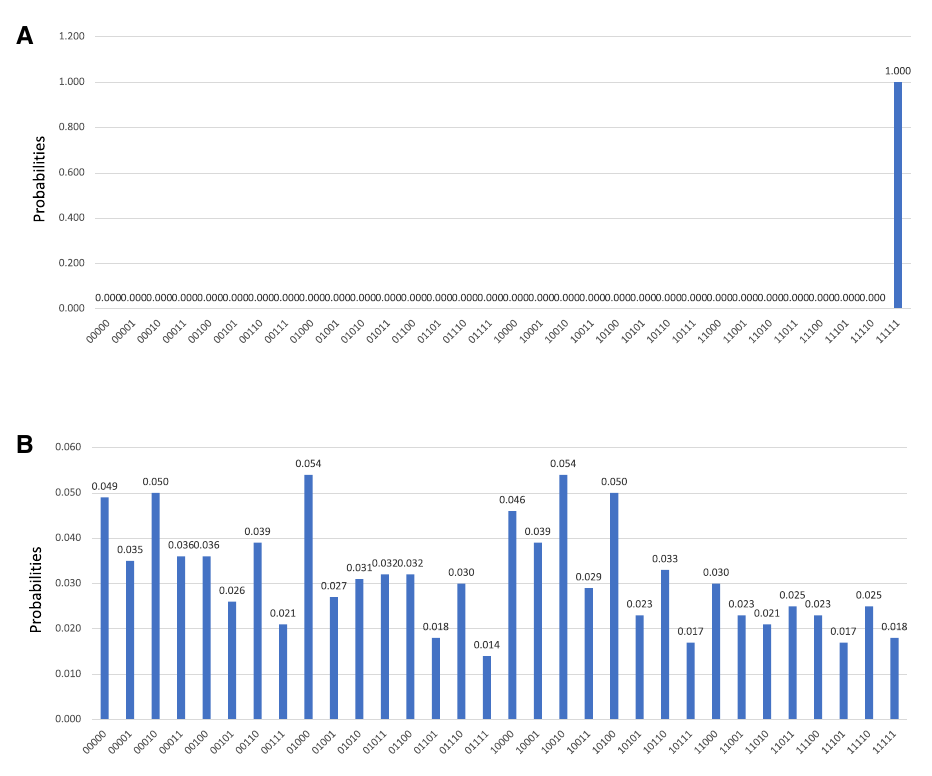
Figure 4. Histogram of probabilities by quantum state with the ATLAS data encoded. (left): The group of four data entries included the target lepton index = 3. The algorithm was run on Qiskit’s ibmq_qasm_simulator backend, a classical simulation. B (right): This group of four data entries contained the target lepton index = 3. The effects of decoherence can be seen. The K–L divergence of the experimental distribution from the simulated distribution is 5.79 The algorithm was run on the quantum device ibmq_16_melbourne.